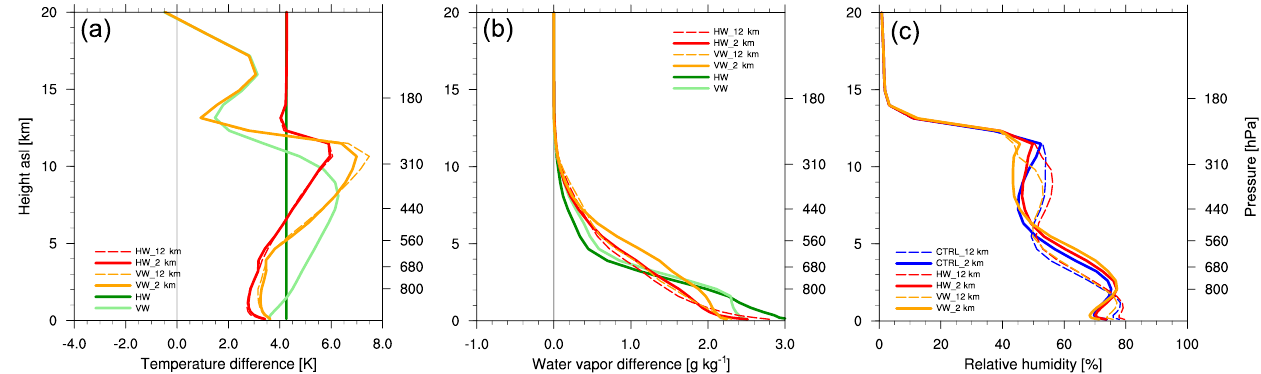
Figure 2. Vertical profiles, averaged spatially inside the analysis domain and over all hours from 3 to 13 June 2007, with respect to the control simulations. (a) Temperature differences of HW (red) and VW (orange) simulations, and at the lateral boundaries of the CPM simulations (green); panel (b) is the same but for specific humidity; and (c) is the same but for relative humidity for all six simulations (control in blue). Dashed lines indicate 12km runs and solid lines 2km runs. Height is indicated in kilometers on the left side and in hPa on the right side of every